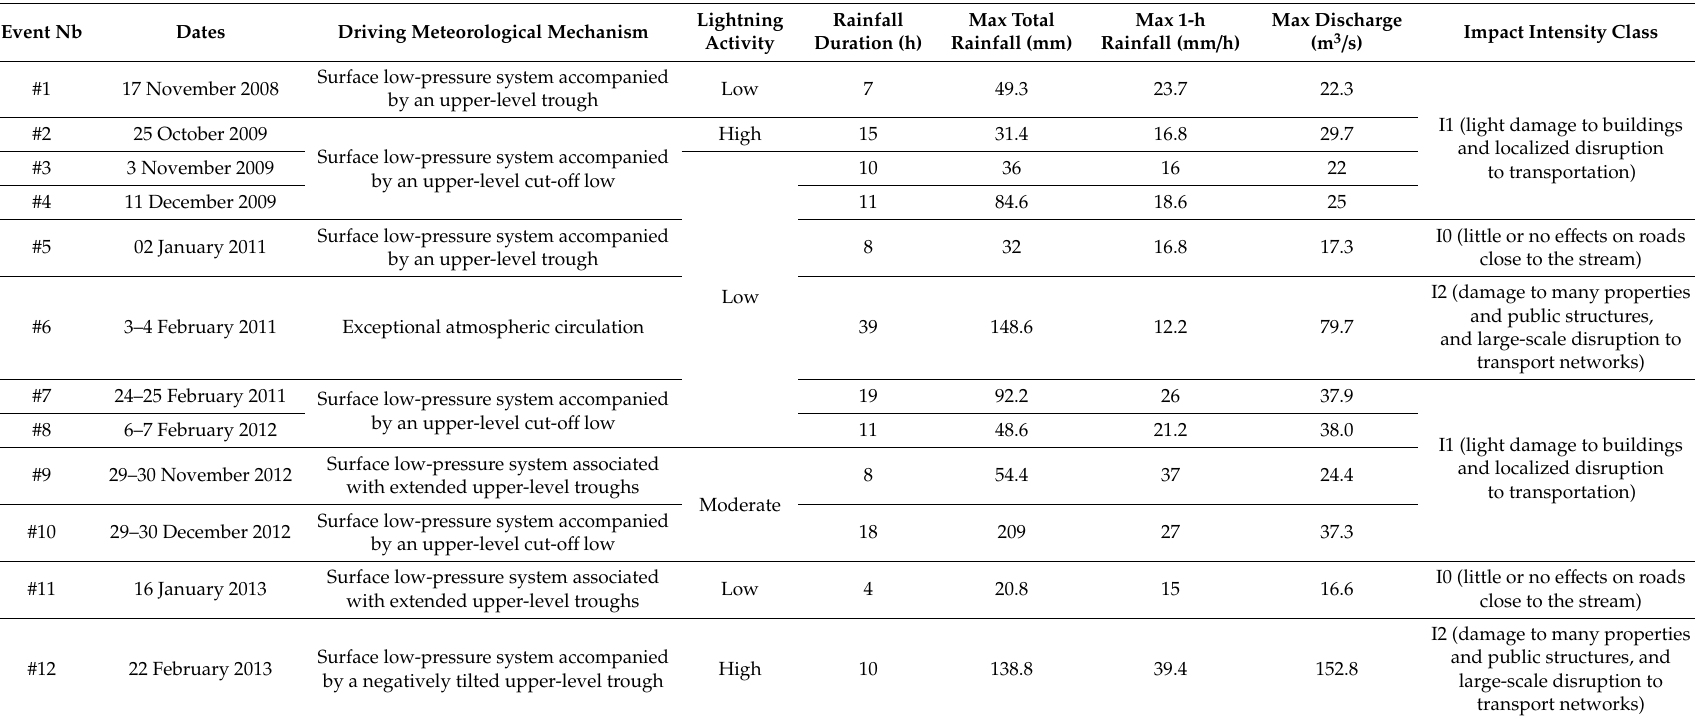
Table 3. Hydrometeorological and impact intensity characteristics of the examined flood